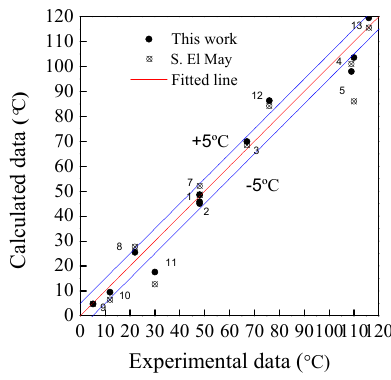
Figure 3. Experimental data at different locations at the ambient temperature of 35 °C.